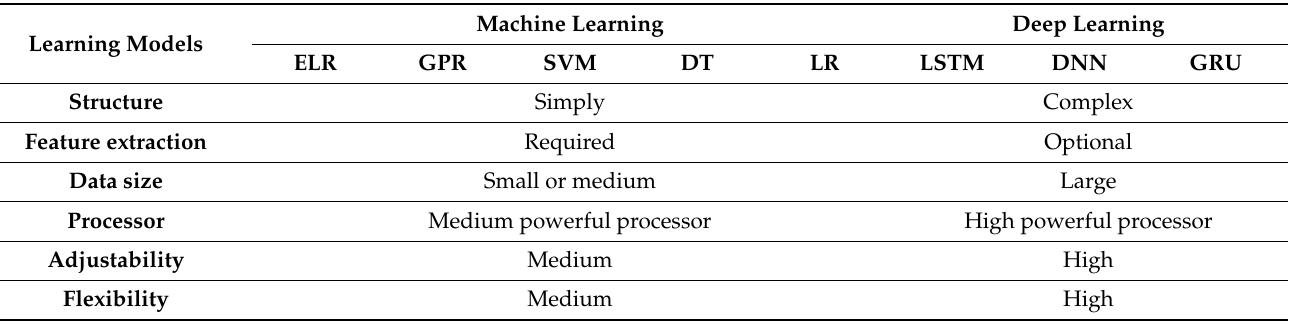
Table 3. Comparison of advanced learning